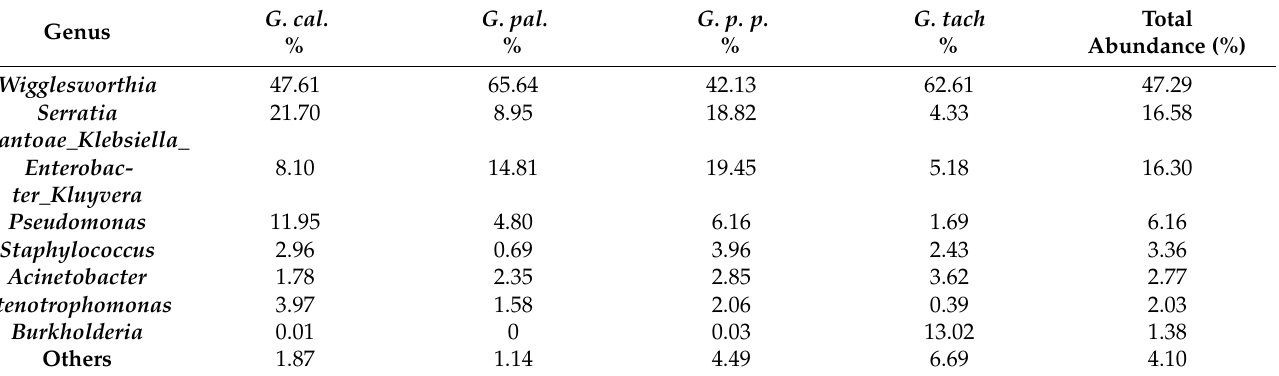
Table 1. Summary of bacterial genera abundance according to the flies’ species.